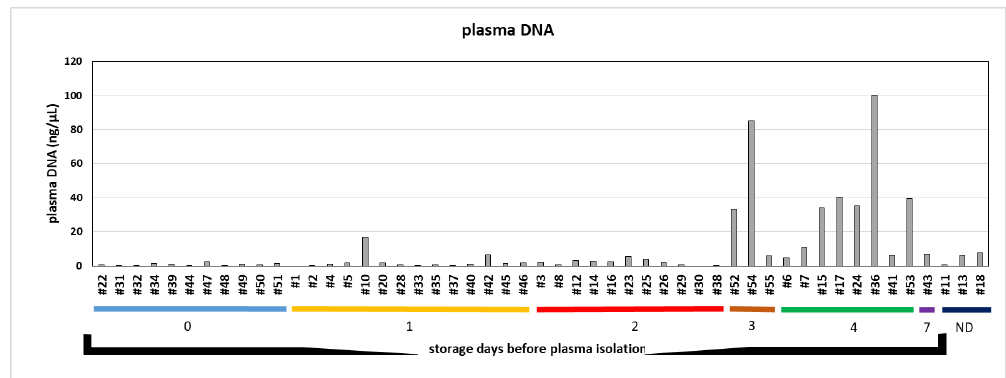
Figure 2. Relevance of time delay for total plasma DNA concentration. Plasma DNA concentrations of plasma samples isolated at different timepoints after venipuncture. Samples#9, #19, #21 and #27 were not processed due to a lack of material (ND = not documented).